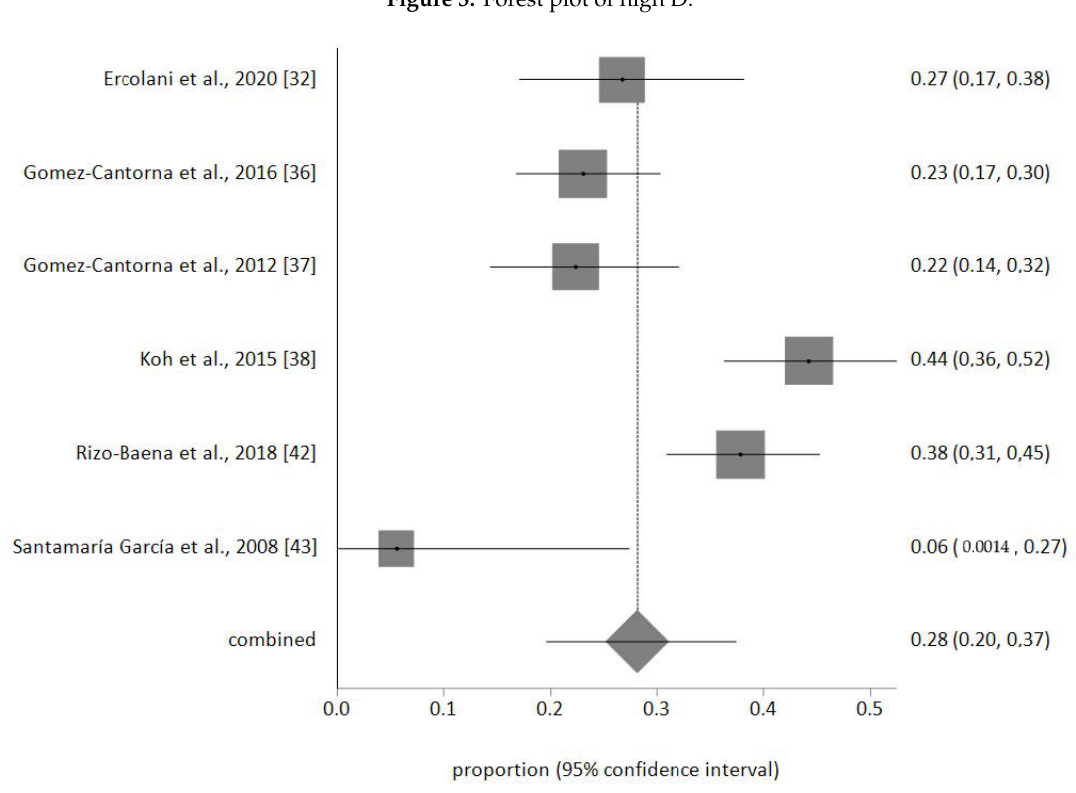
Figure 4. Forest plot of low PA.